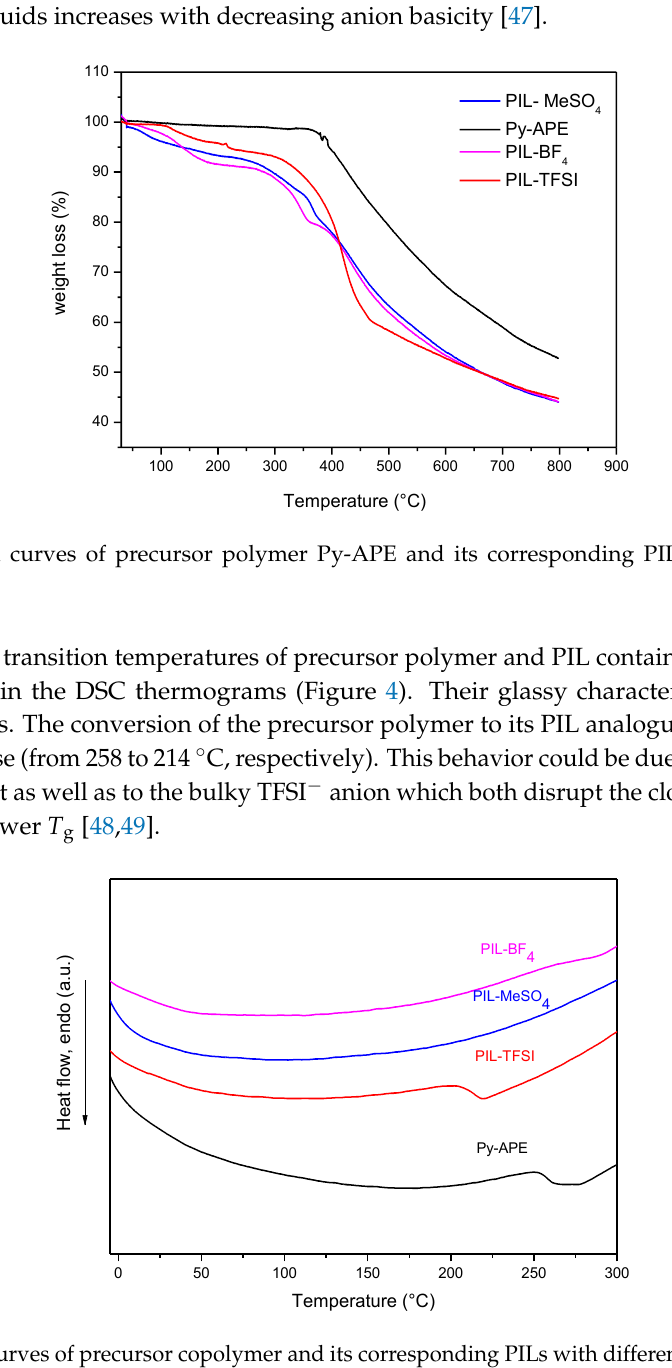
Figure 4. DSC curves of precursor copolymer and its corresponding PILs with different counter anions.